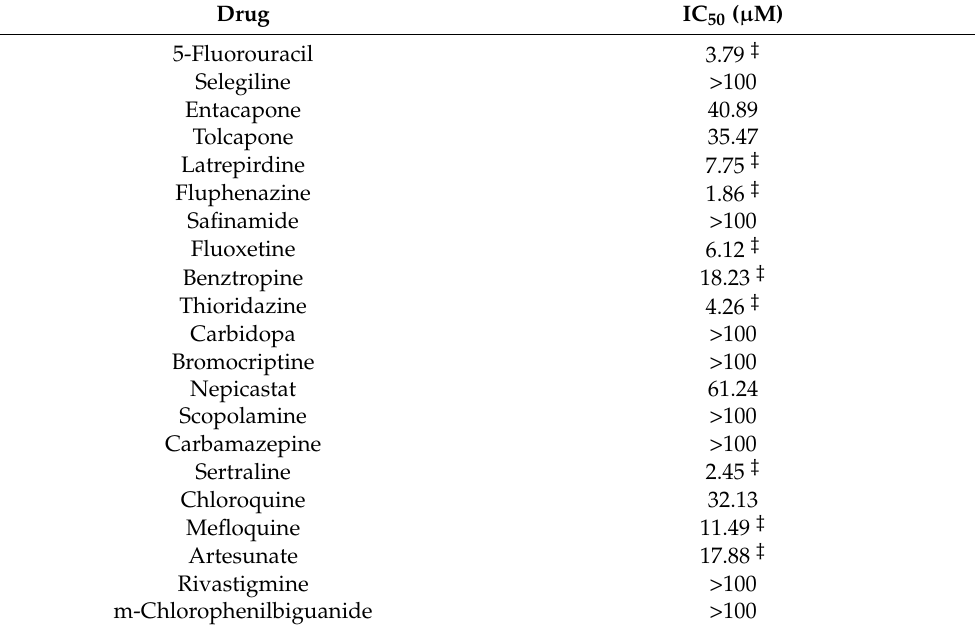
Table 2. Cytotoxicity of 5-FU, several CNS drugs and some antimalarials agents in HT-29 colon cancer cells. IC 50 values are given as